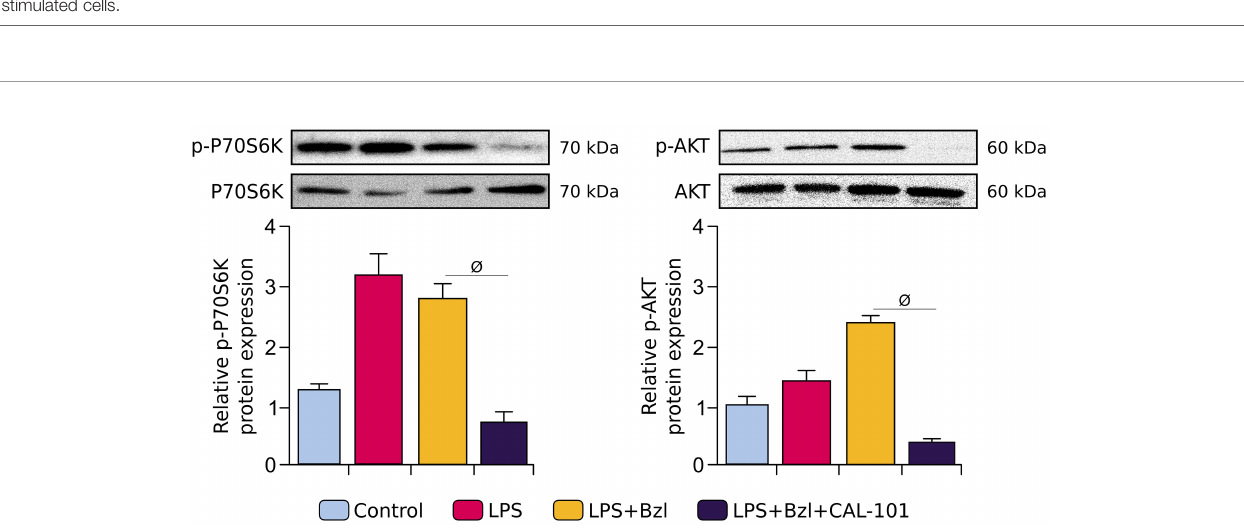
FIGURE 6 | RAW 264.7 macrophages were treated with 10 m M CAL-101, a speci fi c inhibitor of p110 d , the catalytic subunit of PI3K d isoform, 30 min before the addition of 15 m M benznidazole (Bzl). Cells were stimulated with 10 µg/mL of LPS 30 min after Bzl treatment. After 30 minutes, relative p-P70S6K (70 kDa) and relative p-AKT (60 kDa) protein expression was determined by Western blot with a speci fi c antibody and normalized against total P70S6K (70 kDa) and AKT (60 kDa), respectively. Results are expressed as the mean of 3 independent experiments (n=3, 5 replicates/treatment) ± SEM. f P < 0.05 vs. Bzl-treated and LPS-stimulated cells.